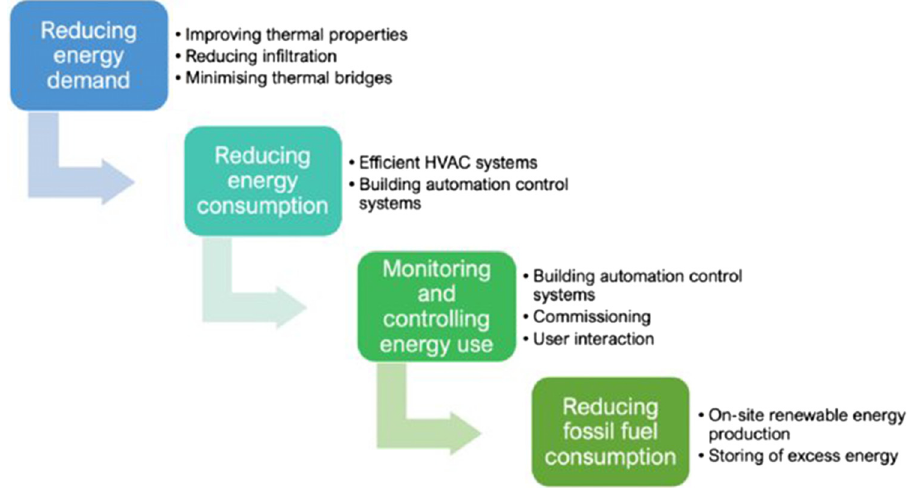
Fig. 9. A Holistic approach for energy ef fi ciency in